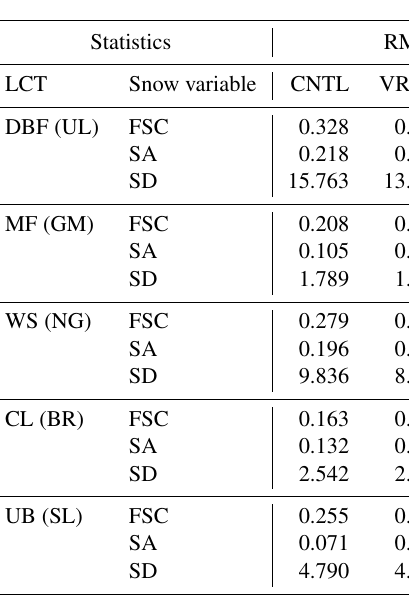
Table 5. Statistics of model performance using non-optimized parameters (CNTL) and optimized parameters (VRF_5 and VRF_6) over different LCTs represented by different stations – DBF represented by UL, MF by GM, WS by NG, CL by BR, and UB by SL. The RMSEs and R 2 values are shown for three snow variables – FSC, SA, and